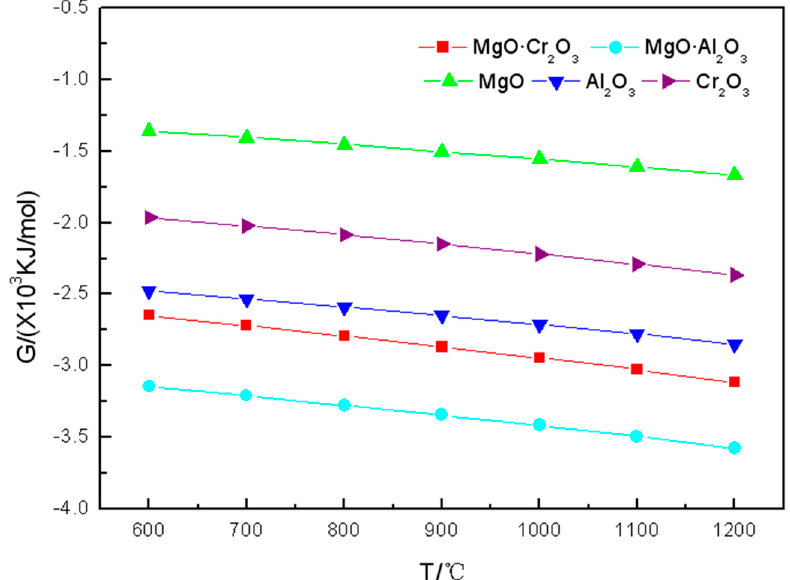
Figure 3. Gibbs free energy of the reaction between KCl and the five components of refractory materials in the 600–1200 °C temperature range.